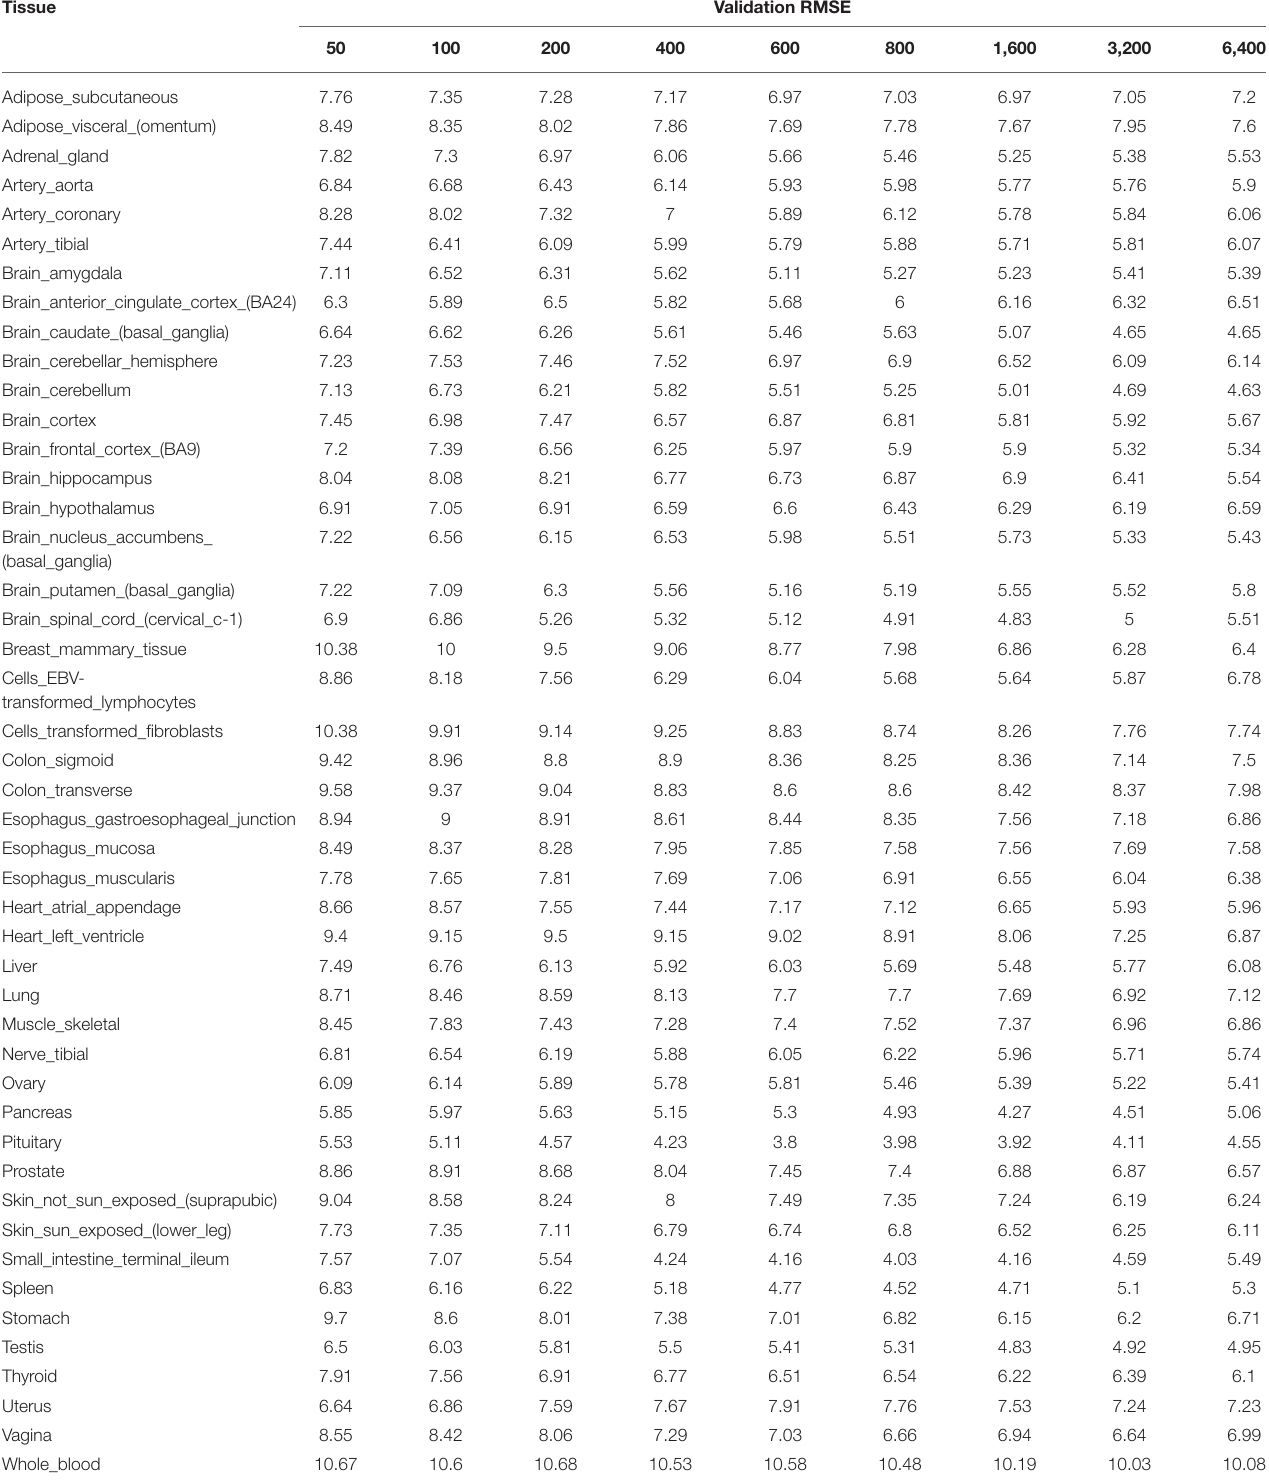
TABLE 2 | Prediction accuracy by using single tissue.